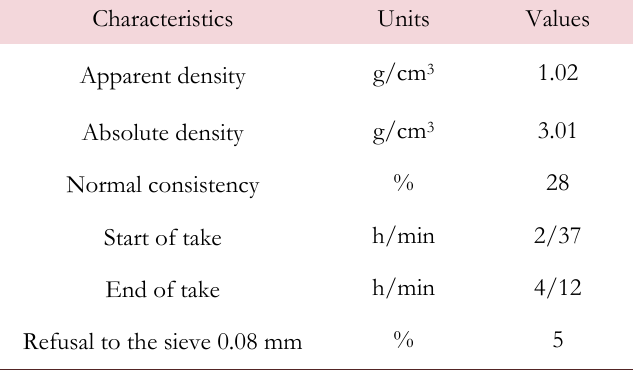
Table 1: Physic-mechanical characteristics of cement